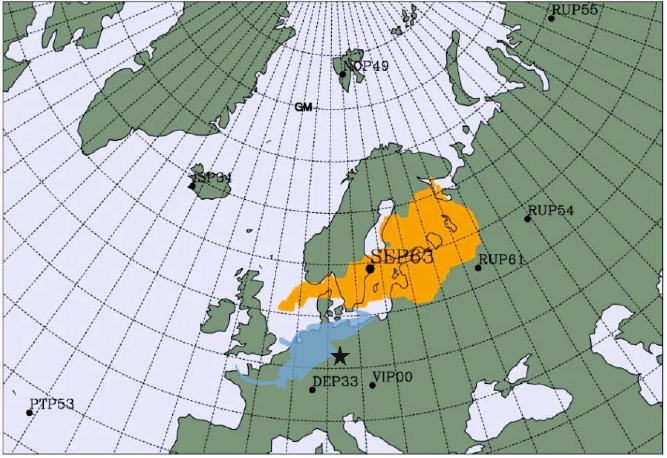
Figure 8. Map issued by the CTBTO showing in orange the possible source region of elevated atmospheric activities of anthropogenic radionuclides recorded on 22/23 June 2020; “DEP33” is indicating the location of station RN33 [39]. The black star shows the rain sampling location. Shaded in blue is the area that resulted from the modelled 60 h back trajectory ensembles discussed in Section 3.1.